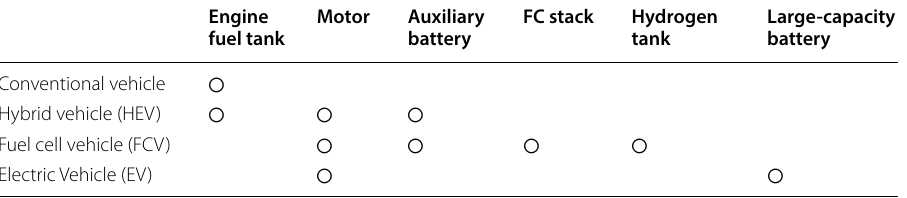
Table 3 Basic structure of next-generation vehicles. Source : Influence of Next Generation Mobility Promotion on the Chubu Region Industries, CRISER